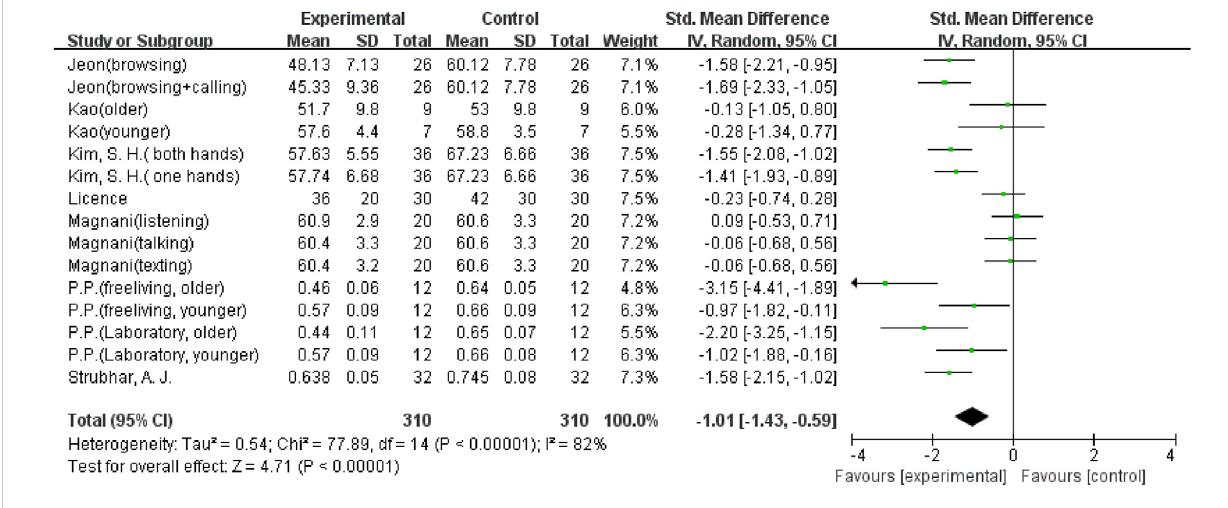
FIGURE 4 The effect of mobile phone use on step length.